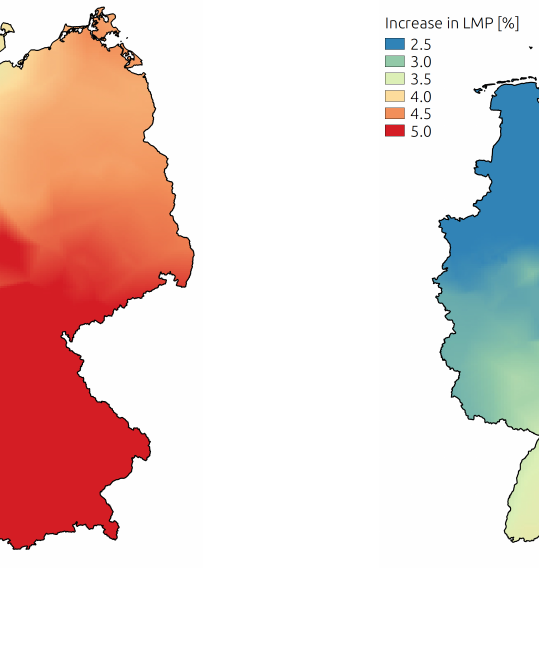
Figure 11. Change in prices at 12:00 on 5 December 2020 of contingent disconnection in Germany’s transmission system, with and without the planned HVDC reinforcements. ( a ) Planned HVDC projects incomplete; ( b ) Planned HVDC projects